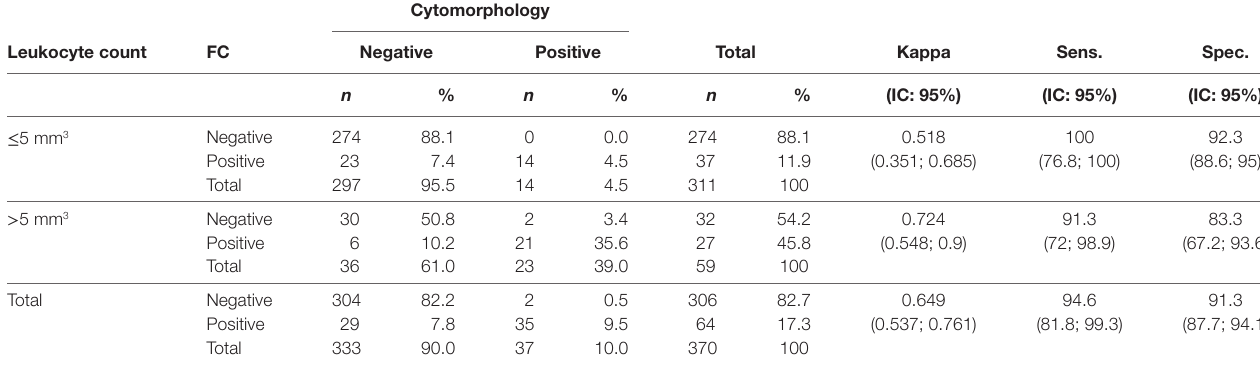
Table 4 | FC versus cytomorphology in the detection of infiltration of the central nervous system by hematologic malignancy.